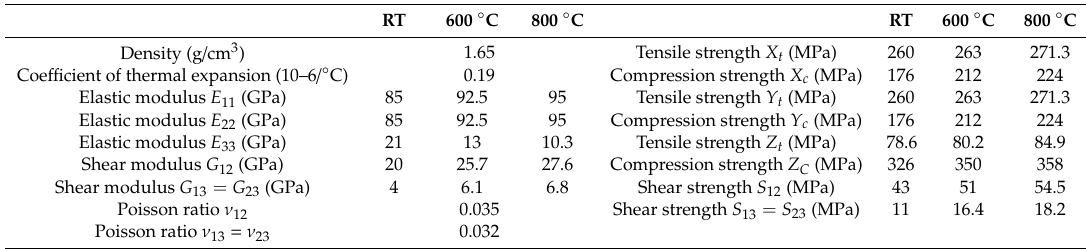
Table 1. Performance of the C / C composites at di ff erent temperatures.